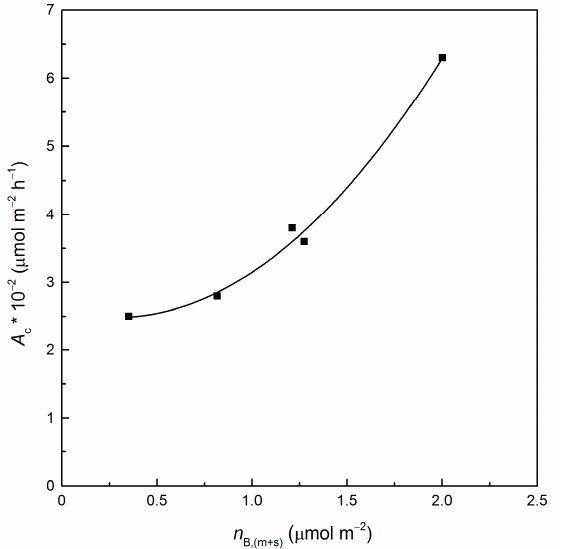
Figure 6. Catalytic activity as a function of medium-strength and strong basic sites’ concentration. Experimental conditions: T = 160 °C; autogenic pressure (15 bar); CH 3 OH/PC = 10 mol/mol; catalyst/PC = 0.03 g/g; reaction time = 4 h.